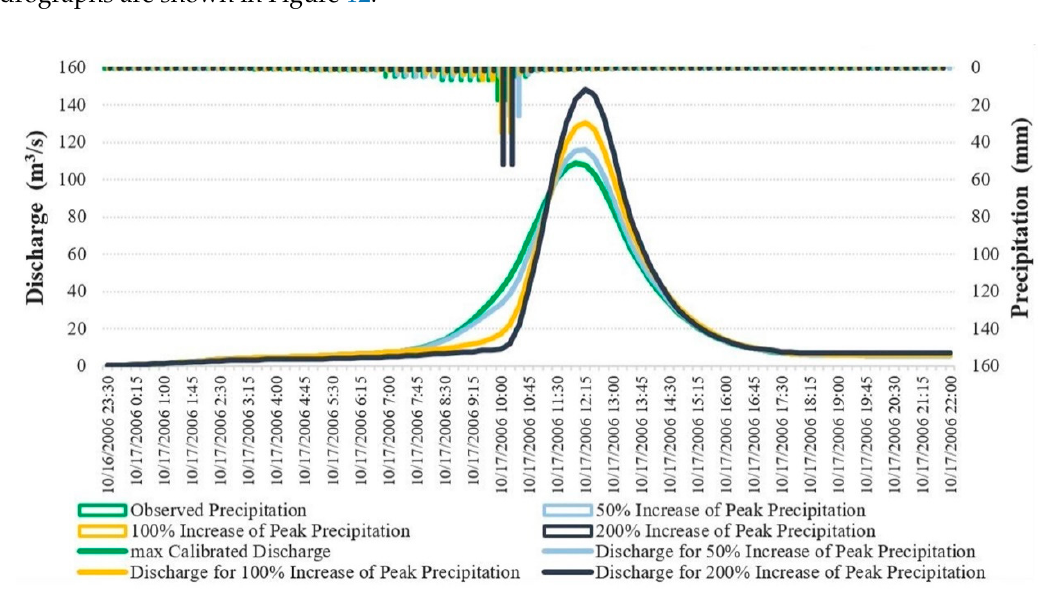
Figure 12. Rainfall and flow hydrograph due to scenarios of increasing peak rainfall by factors of 1.5, 2.0, and 2.0, and 3.0.